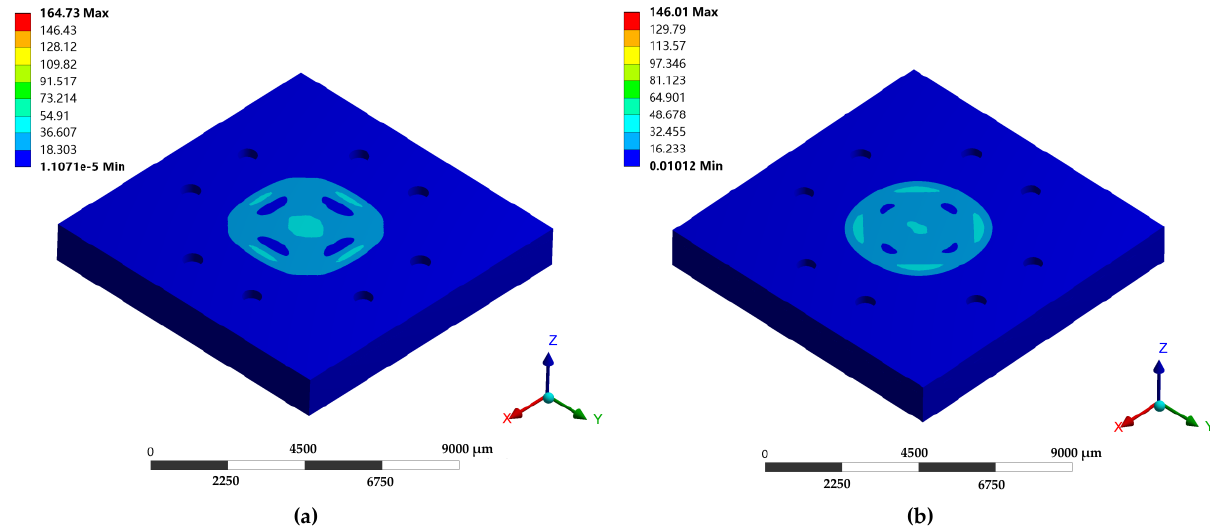
Figure 3. ( a ) Structural simulations under 7000 kPa: ( a ) the microsensor with square pressure-sensitive diaphragm (side length of 4.4 mm); ( b ) the microsensor with circular pressure-sensitive diaphragm (diameter of 4.4 mm). Table 2. Parameters of chips with different vacuum cavity sizes.